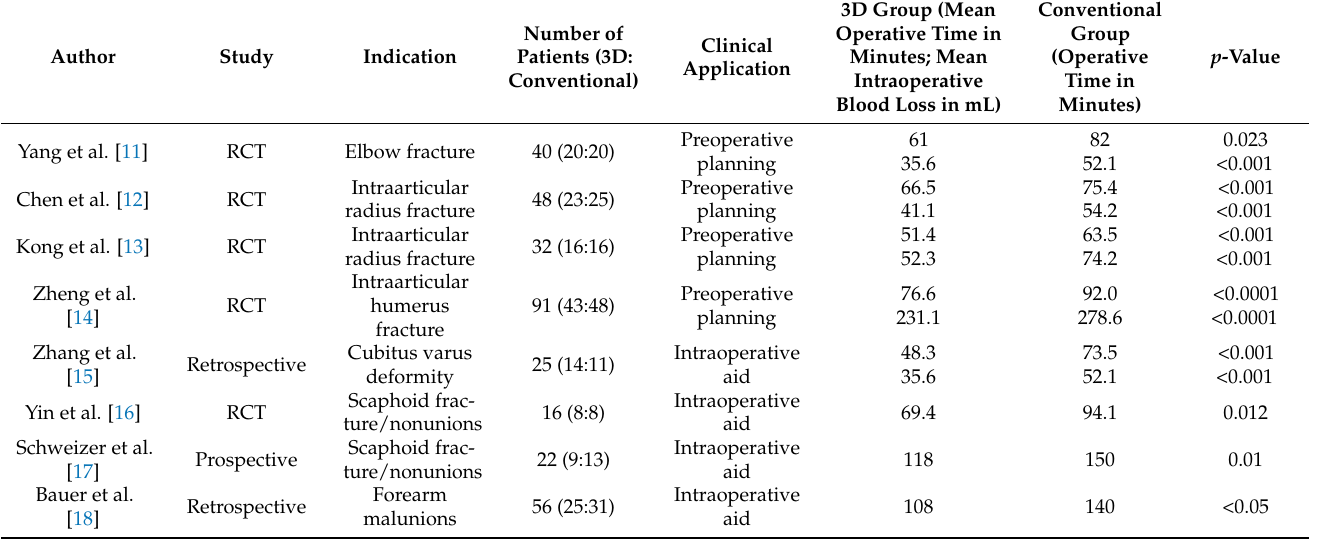
Table 1. Operation time and intraoperative blood loss of included comparative clinical studies; 3D = three-dimensional; RCT = randomized controlled